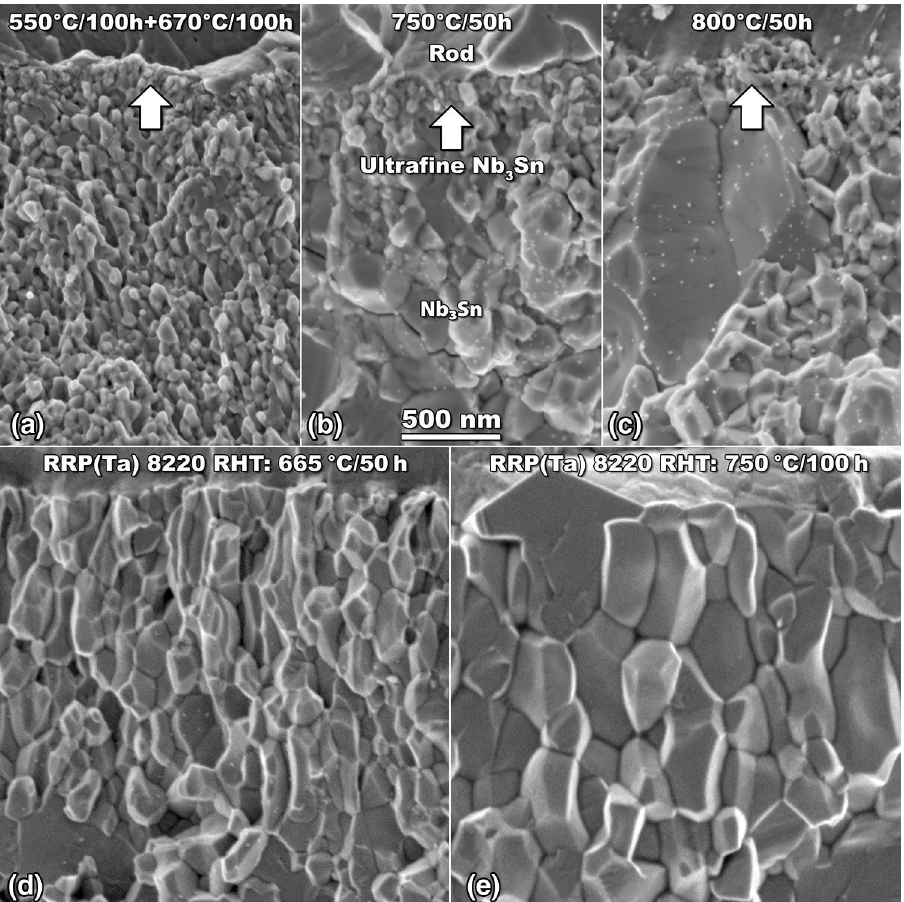
Figure 3. SEM characterization of Ta-Hf-doped Nb 3 Sn compared with standard Ta-doped Nb 3 Sn. Fractographs of Nb 3 Sn grains after heat treatments at different temperature for Ta-Hf-doped samples made with home-made Nb4Ta1Hf special alloy ( a – c ) and for Ta-doped RRP wire made with industrial Nb4Ta ( d , e